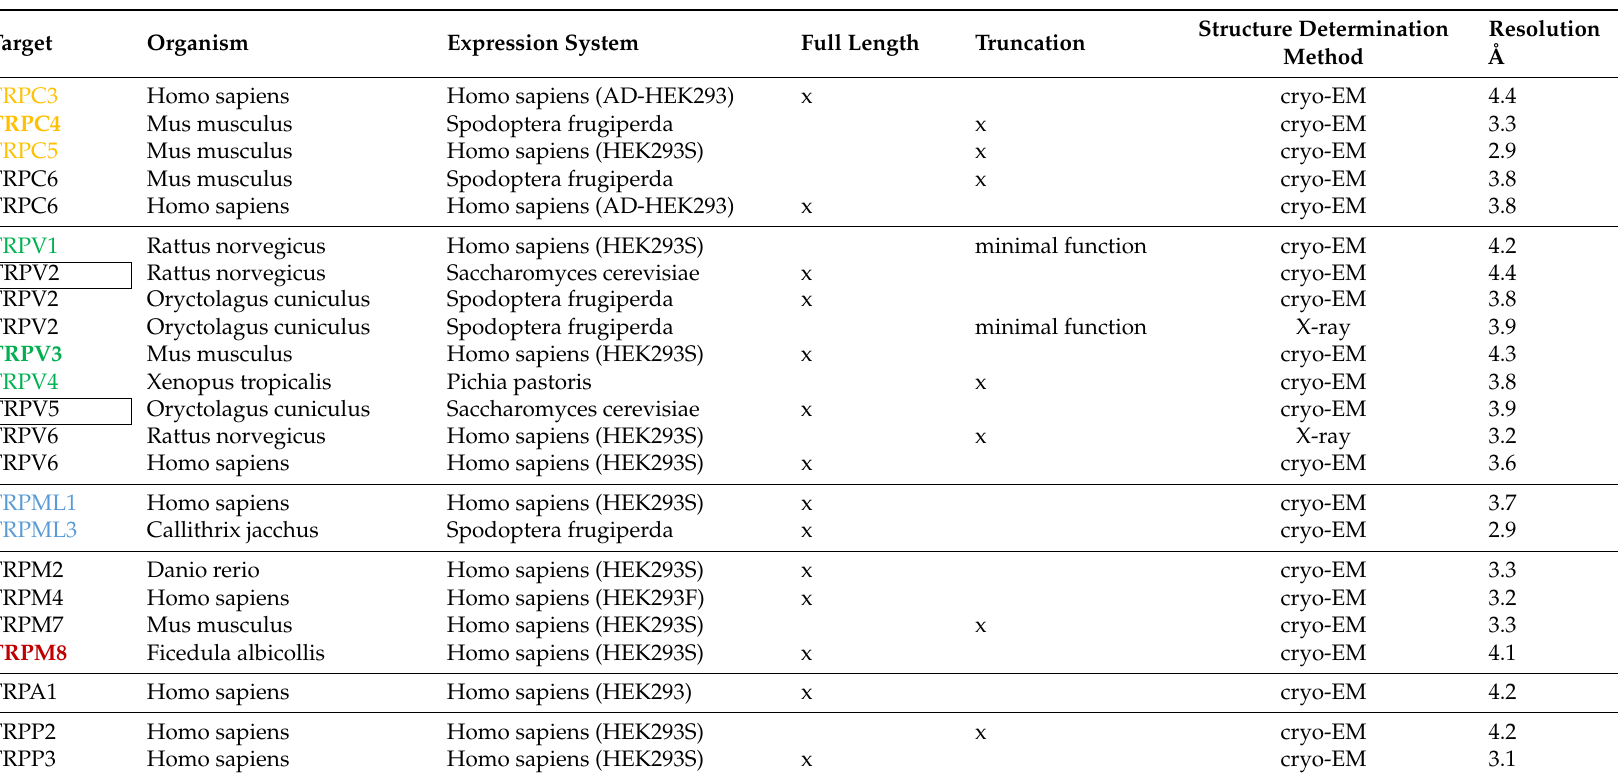
Table 1. Structurally determined TRP channels. TRP channels produced in Saccharomyces cerevisiae are framed. Targets included in this study are indicated in colors (yellow, green, blue and red represent TRPC, TRPV, TRPML and TRPM subfamilies, respectively). Boxes indicate the recombinant proteins produced in yeast, targets purified in this study are shown in bold. Additional information about constructs, structure determination method and obtained resolution are also